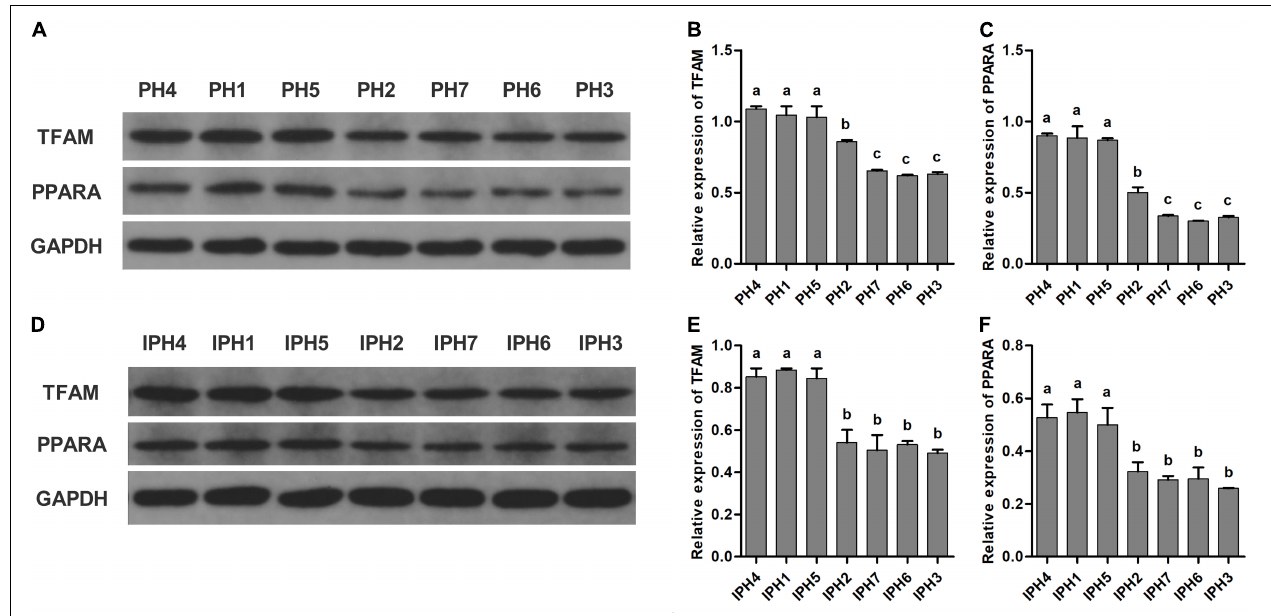
FIGURE 5 | Measurements of PPARA and TFAM in fibroblasts and cybrids by western blot assays. (A,D) Illustrations of western blotting images in fibroblasts and cybrids; (B,C) protein levels of TFAM and PPARA in fibroblasts; (E,F) protein contents of TFAM and PPARA in cybrids. Different letters on columns meant significant differences at P < 0.05 levels. PH1-7, fibroblast with mitotype 1–7, respectively; IPH1-7, cybrid with mitotype 1–7,